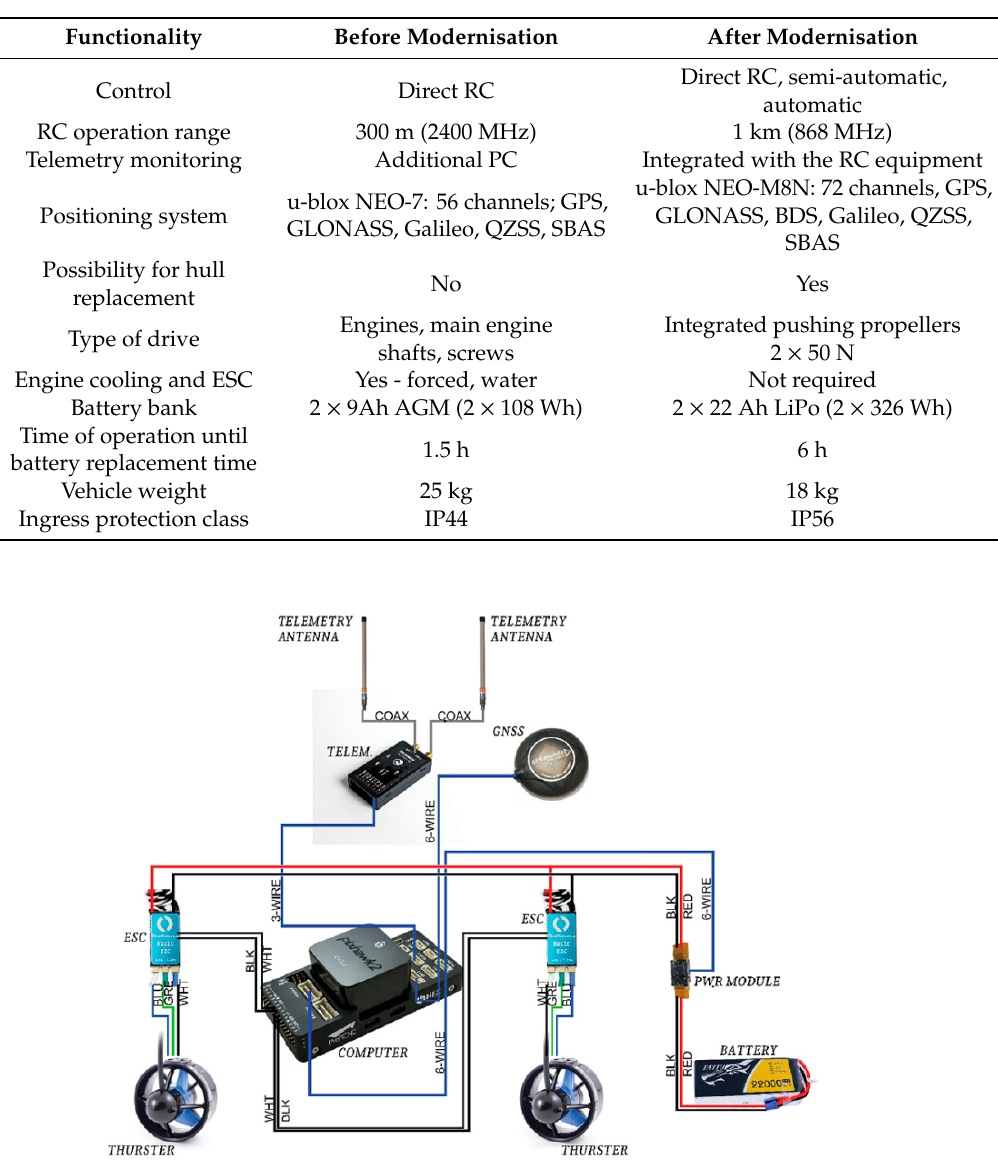
Table1. AsummarycomparisonoftheUSVfunctionalityparametersbeforeandafterthemodernisation.